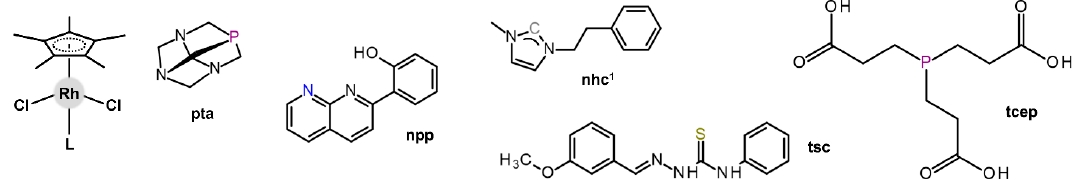
Figure 2. The general structural formula of the [Rh( η 5 -Cp*)(L)Cl 2 ] complexes and structural formulas of selected monodentate L ligands, with the donor atoms given in magenta (P), blue (N), grey (C) or dark yellow (S).